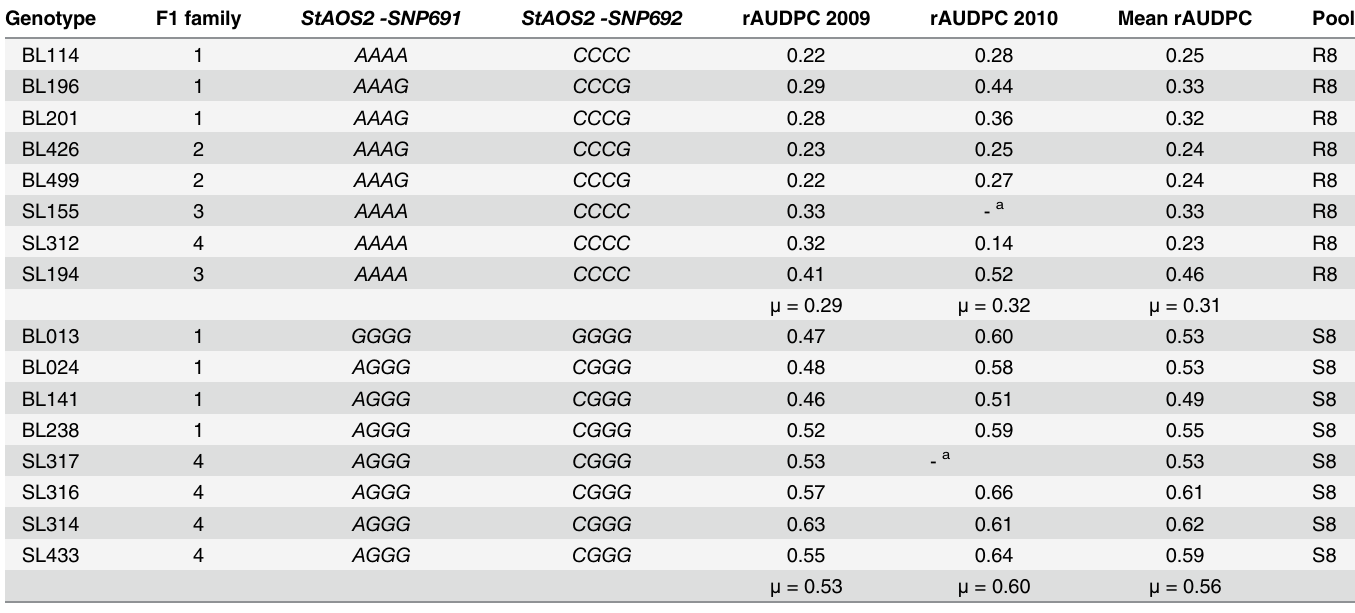
Table 3. StAOS2 SNP genotypes and late blight resistance phenotypes of the potato plants used to compose the samples for RNA-Seq